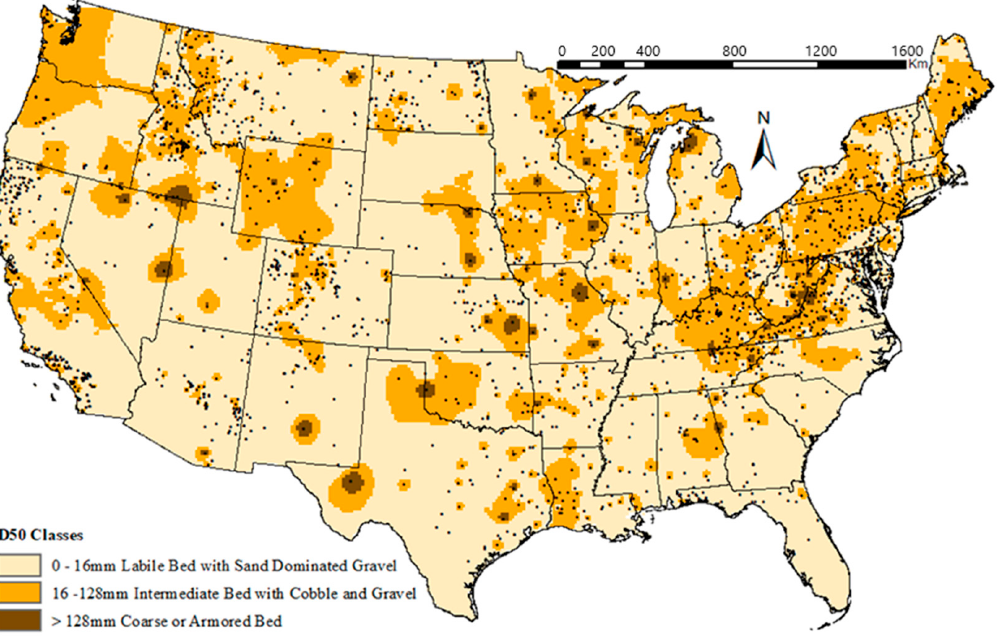
Figure 11. Map of interpolated D50 over the Contiguous U.S. using broad categories of streambed material. Note: The map was prepared using the log value of more than 2200 D50 data points collected from five sources; black dots on the map show the locations of D50 data points.